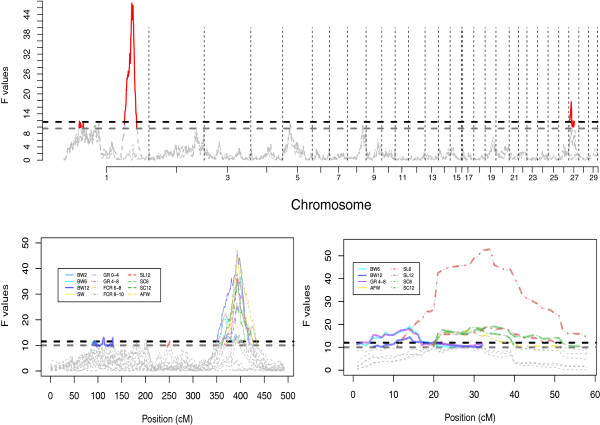
QTL profiles from the one-dimensional scan of the indigenous × commercial broiler F2 intercross. a) Genome-wide QTL profile for body weight at 10 weeks of age trait (BW10), b) and c) Chromosome scans for the six groups of phenotypes for GGA1 and GGA27, respectively. In a), the dashed black and grey horizontal lines denote the 1% and 5% genome-wide significance thresholds, respectively, while dashed vertical lines separate the chromosomes. Curves are dashed and grey in non-QTL regions and coloured in red for inferred QTL regions. b) and c) show the two major QTL on GGA1 and GGA27 detected in our study to illustrate the consistent peaks among different traits. For those traits with coherent records throughout the whole growth period, only the ones representing different growth stages are included.